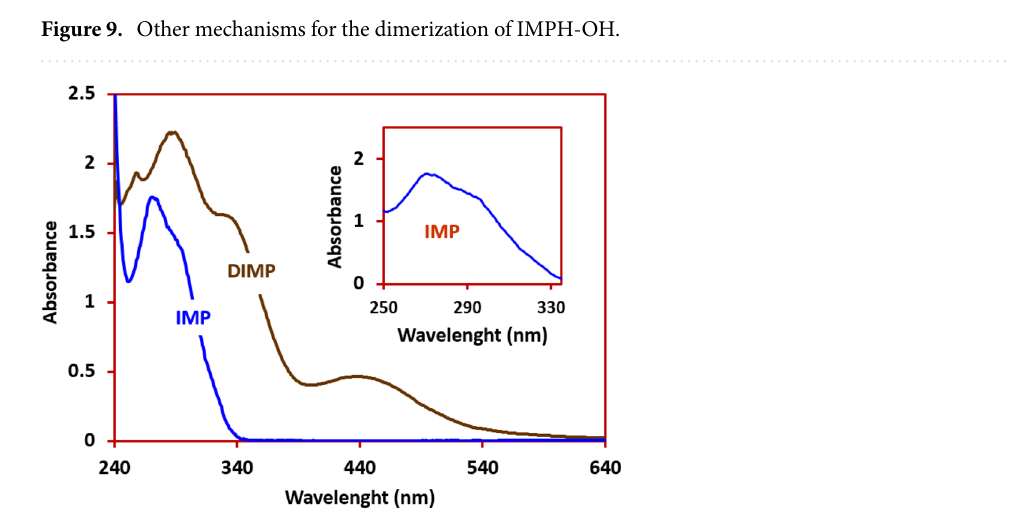
Figure 10. UV–visible spectra of IMP (0.5 mM) and DIMP (0.5 mM) in CHCl 3 . Inset: expanded